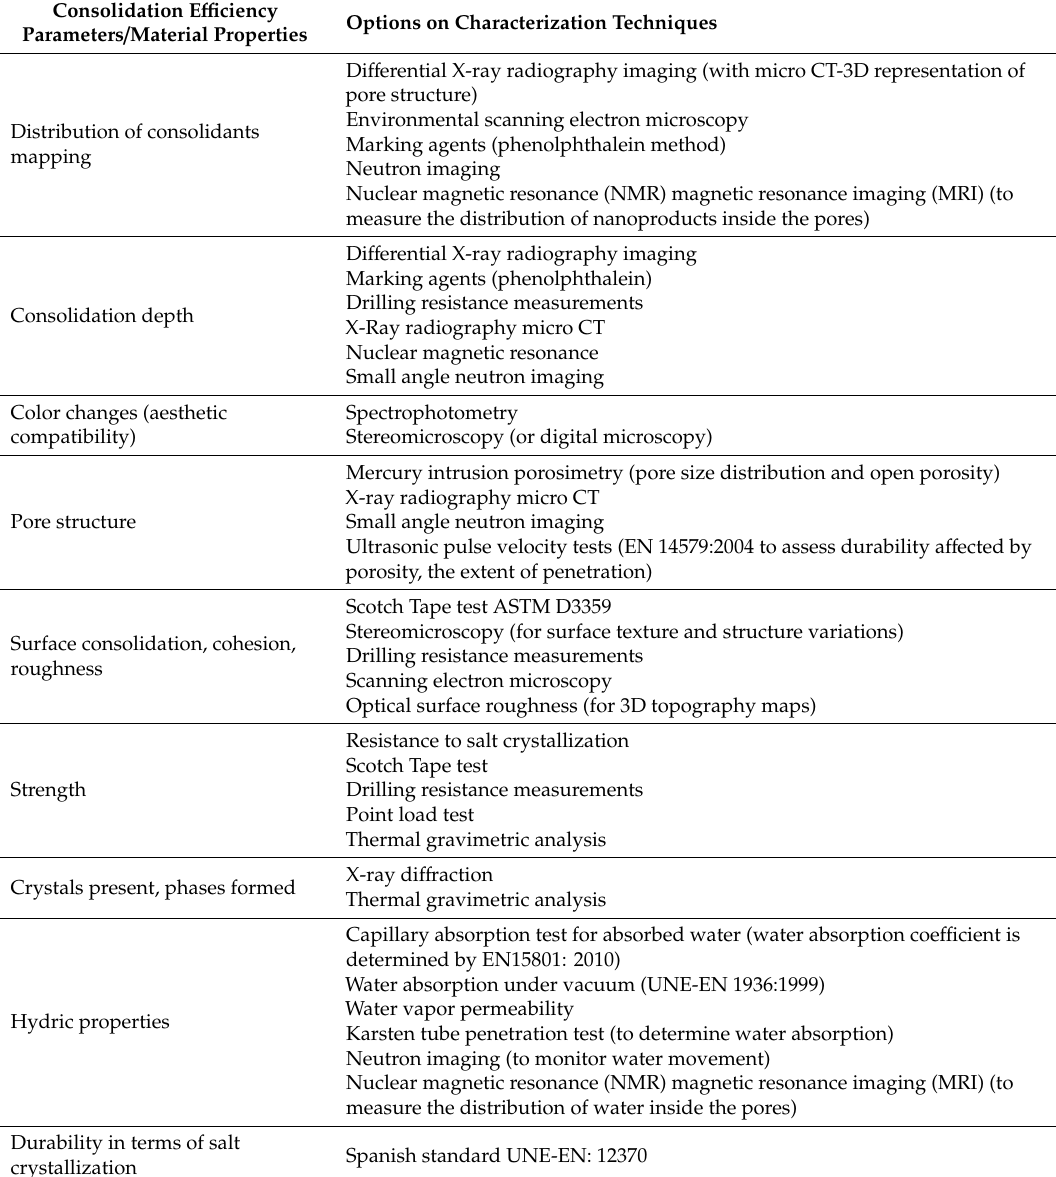
Table 4. Efficiency parameters / material properties to be assessed and options available for